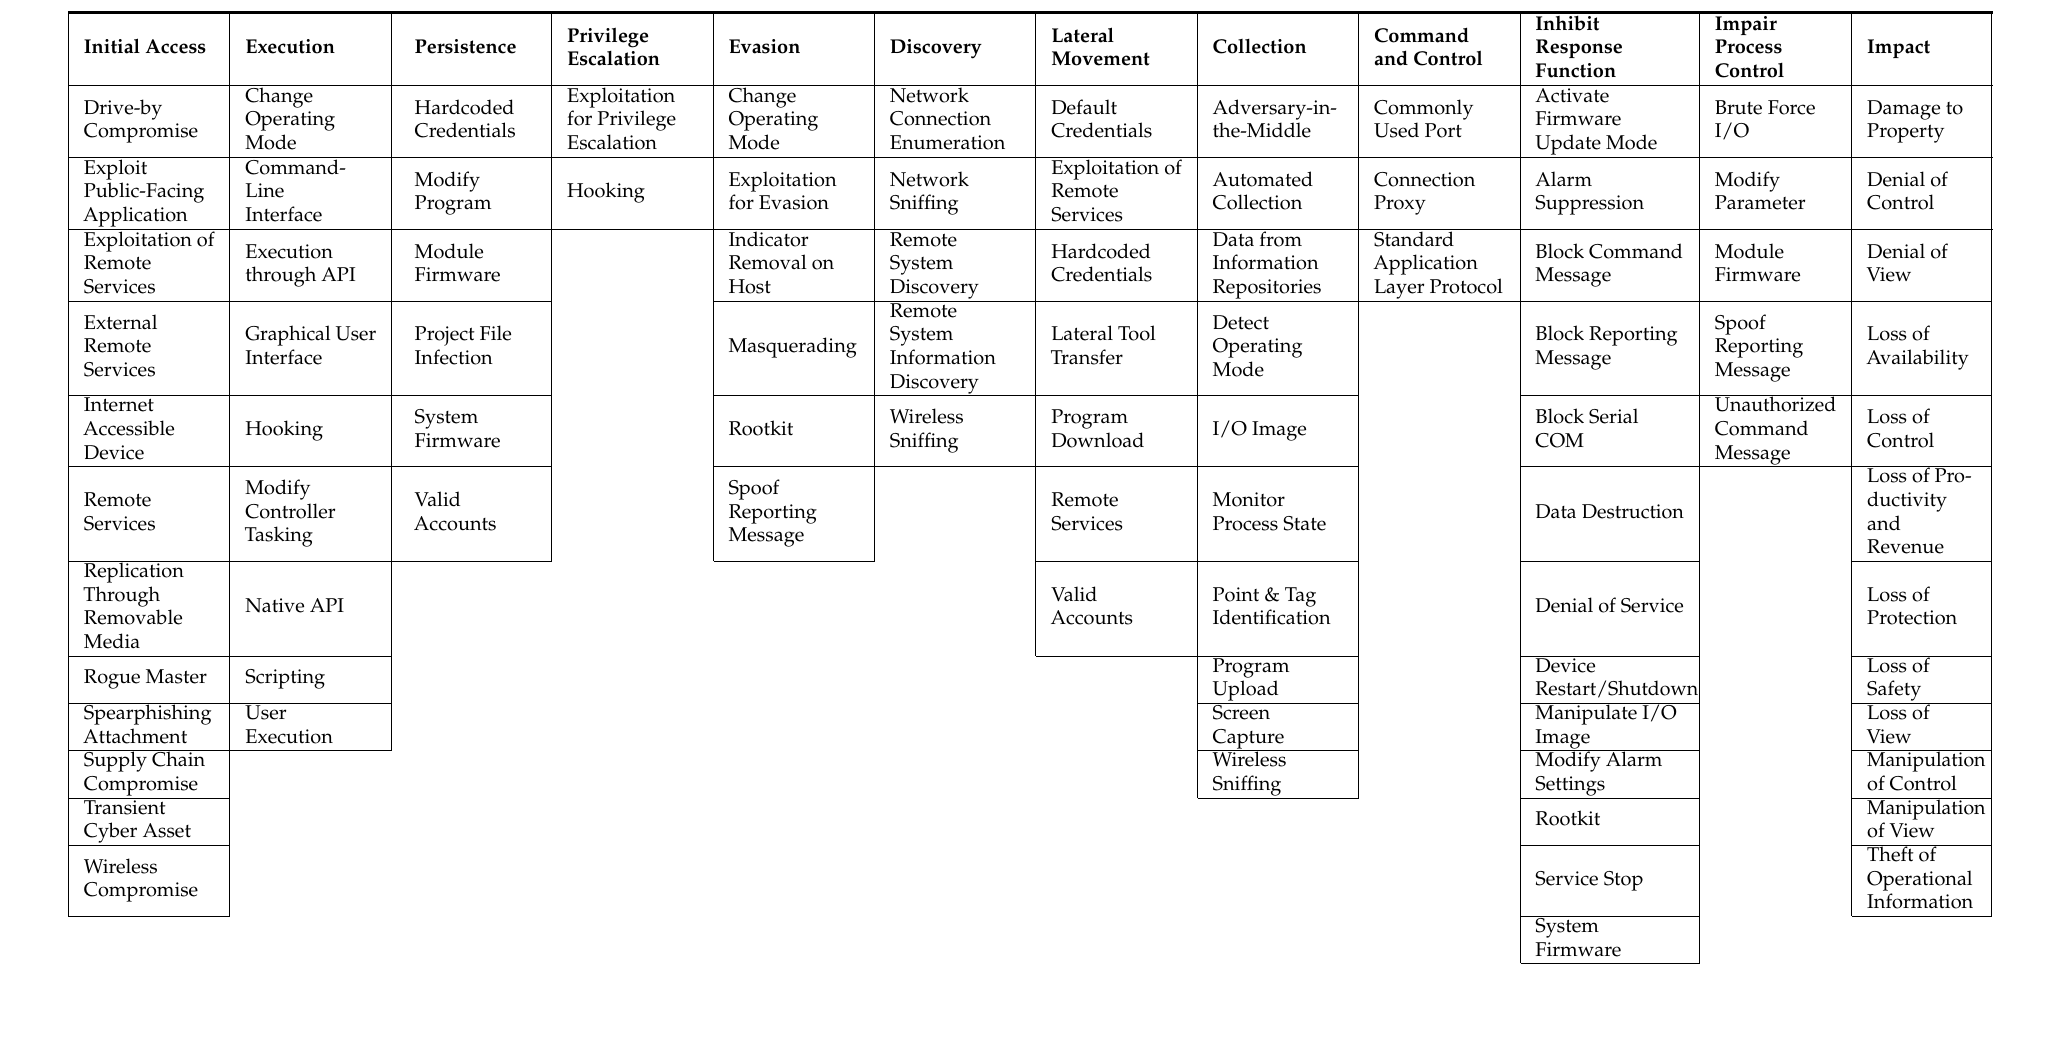
Table 2. Complete MITRE ATTACK Matrix for ICS—top level techniques as of November 2022